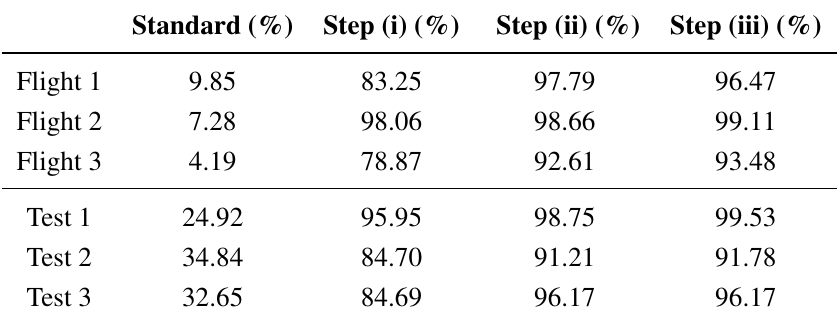
Table 2. Single-epoch ambiguity resolution success